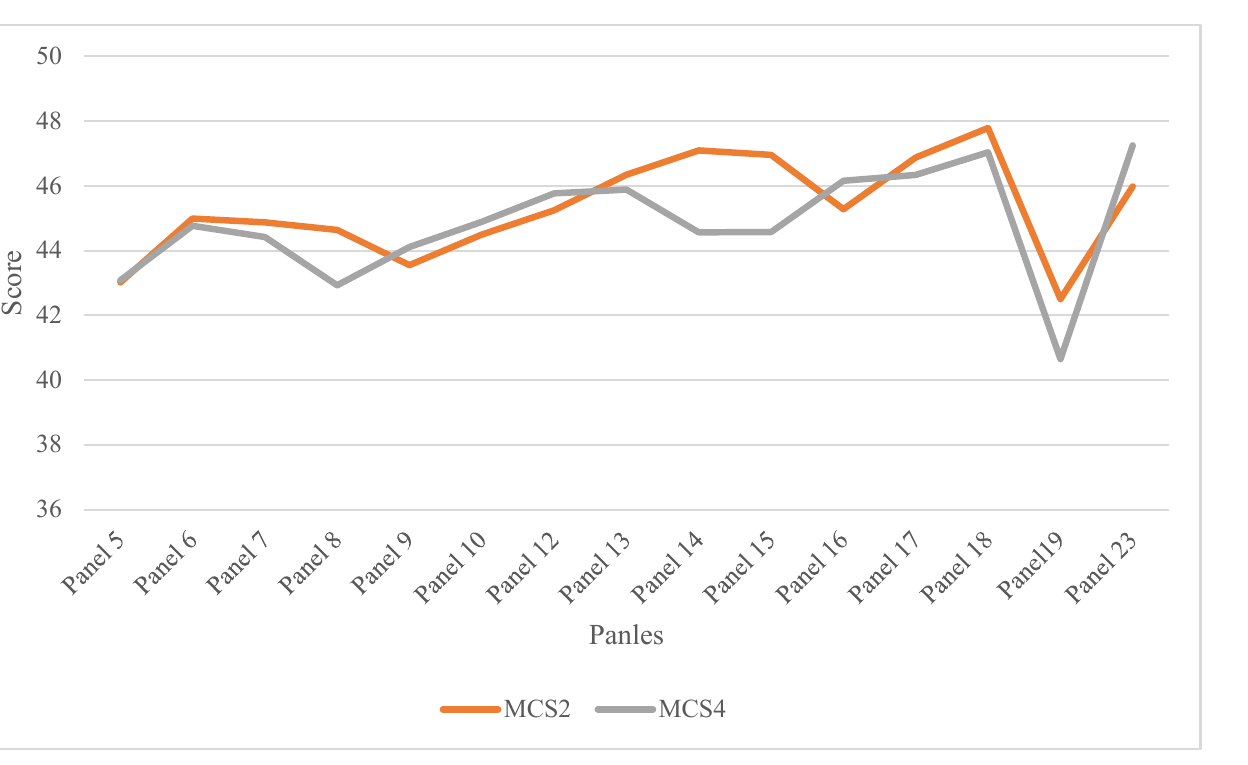
Figure 2. The trend of physical component score (PCS) domain, panels 5–23. Panels 11, 20, 21, and 22 are not shown in the graph due to an incomplete record of HRQOL. PCS2: physical component score in round 2, PCS4: physical component score in round 4. 3.3. Factors Associated with Health ‐ Related Quality of Life of Diabetes Patients To determine factors associated with HROQL, we ran a multinomial logistic regres ‐ sion. It was found that, among many factors, age, race, and antidiabetic medications were found to be associated with HRQOL. The relative risk for improved mental HRQOL status relative to unchanged status increased by 50% in patients aged 40 to 49 and 60 to 69 years old (0.53 [95 CI% 0.27–0.92, p = 0.02] and 0.50 [95 CI% 0.32–0.98, p = 0.02], respectively), as compared with patients aged between 18 and 39. Relative to Hispanics, the relative risk of improved mental HRQOL relative to unchanged mental HRQOL was 48% lower for